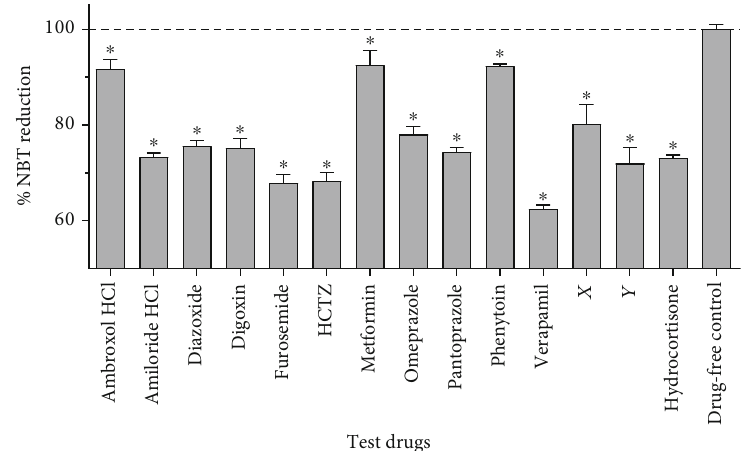
Figure 2: E ff ects of ion transport modulators on the production of superoxide by THP-1-derived macrophages. Macrophages were stimulated with ethanol-inactivated M. bovis BCG in the presence of the test drugs over 30 minutes, and production of superoxide was assessed using the NBT assay. Superoxide production was compared between the di ff erent cultures using one-way analysis of variance (ANOVA) followed by Dunnett ’ s post hoc test. Data are presented as mean (+SD) of six replicates pooled from two independent experiments. The dotted line indicates superoxide production in drug-free controls. ∗ indicates p < 0 : 05 vs. drug-free controls. HCTZ: